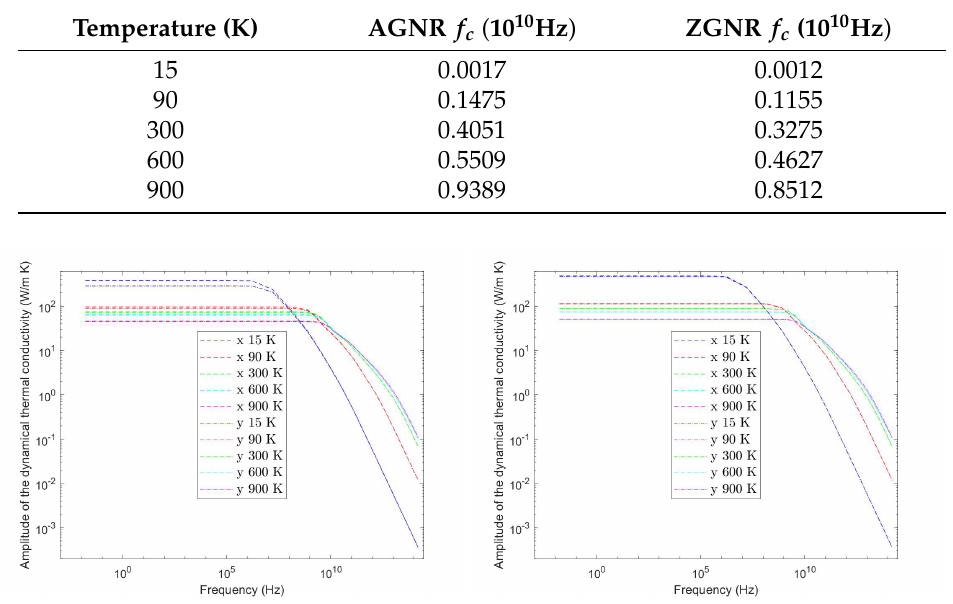
Figure 22. Amplitude of the dynamical conductivity in the x- and y-directions for an armchair ( left ) and zig–zag ( right ) GNR with width equal to 40